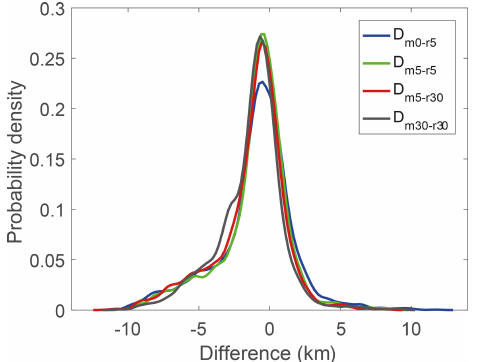
Figure 5. Locations of the AHI CTHs (circles) and the IAP Ka radar (solid black dots). The spatial resolution of the AHI CTH data of the full disk does not